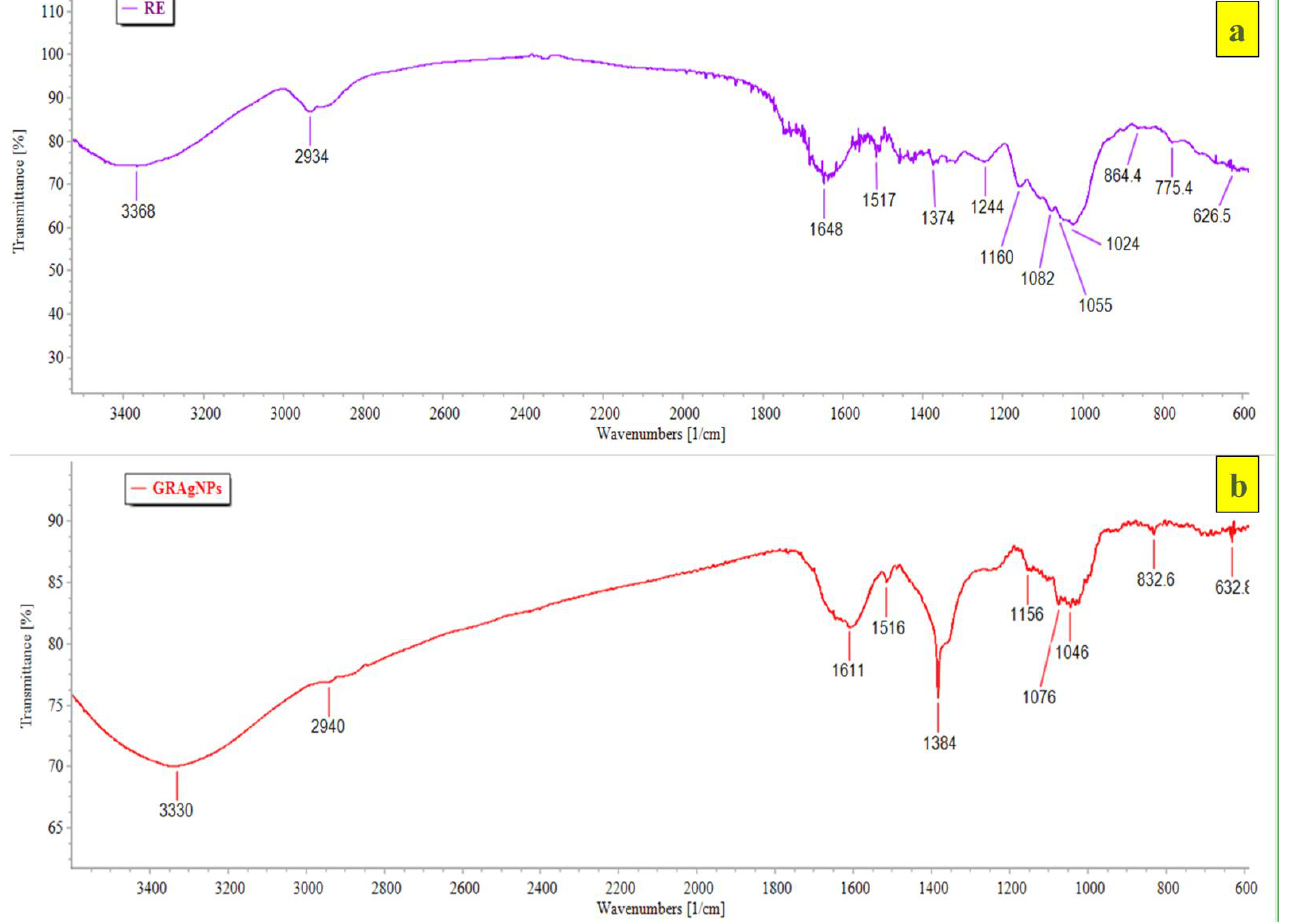
Figure 3. FTIR profile of ( a ) aqueous root extract of G. glabra (RE), ( b ) silver nanoparticles synthe- sized using aqueous root extract of G. glabra (GRAgNPs) and ( c ) commercial silver nanoparticles (CAgNPs) depicting spectral bands at various positions. 3.2. Bio-efficacy of GRAgNPs